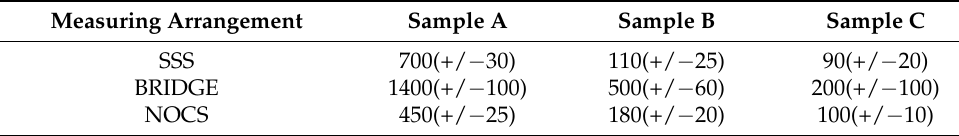
Figure 16. Close up of specimen C, 50 mm cover.